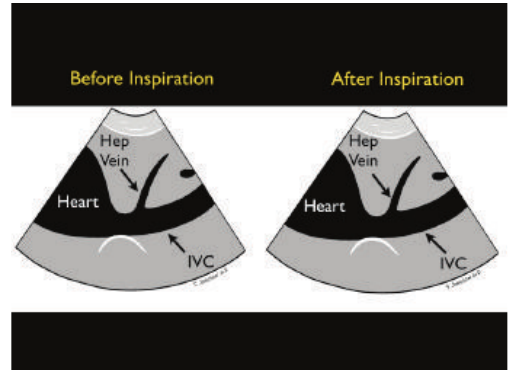
Figure 16: Large, distended internal jugular vein, short axis view. IJ: internal jugular vein, CA: carotid artery.